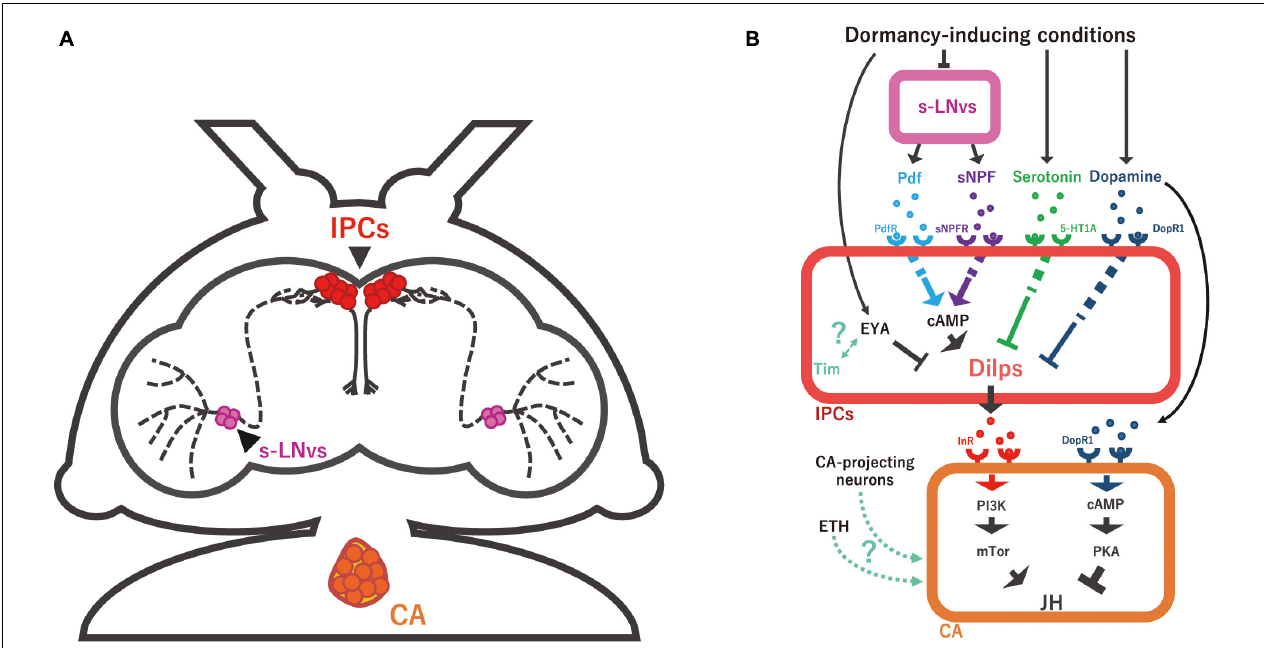
FIGURE 3 | Schematic representation of the neuroendocrine mechanisms regulating JH biosynthesis. (A) Anatomy of small ventral lateral neurons (s-LNv; magenta), insulin-producing cells (IPCs; red), and the corpus allatum (CA) in D. melanogaster adult female. s-LNvs are the circadian clock pacemaker neurons whose axons seem to have direct synaptic connections with IPCs. (B) The s-LNv-IPC-CA axis and multiple humoral factors to regulate JH biosynthesis in the CA. Under dormant conditions, the secretion of pigment-dispersing factor (Pdf) and short neuropeptide F (sNPF) from s-LNv is reduced, followed by the suppression of IPC activity and consequently that of Dilp production. Serotonin and dopamine are also involved in inducing reproductive dormancy by repressing Dilp expression in IPCs. It is noteworthy that, whereas it is generally considered that serotonin receptor (5-HT1A) and dopamine receptor (DopR1) positively evoke intracellular cAMP level, it is unclear how serotonin-5-HT1A and dopamine-DopR1 signaling negatively regulate Dilp expression, differently from Pdf-Pdf receptor (PdfR) and sNPF-sNPF receptor (sNPFR) signaling. In addition to these hormones and neurotransmitters, Dilp expression is intracellularly regulated by the transcriptional regulator Eye absent (Eya) and possibly the core circadian clock gene timeless (Tim). Dilps and Ecdysis-triggering hormone (ETH) have a function to promote JH biosynthesis in the CA. On the other hand, dopamine has a function to suppress JH production in the CA under dormancy-inducing conditions. In many insects, direct projection nerves of the CA are essential for the regulation of reproductive dormancy, while it is still unclear whether this is also the case in D.